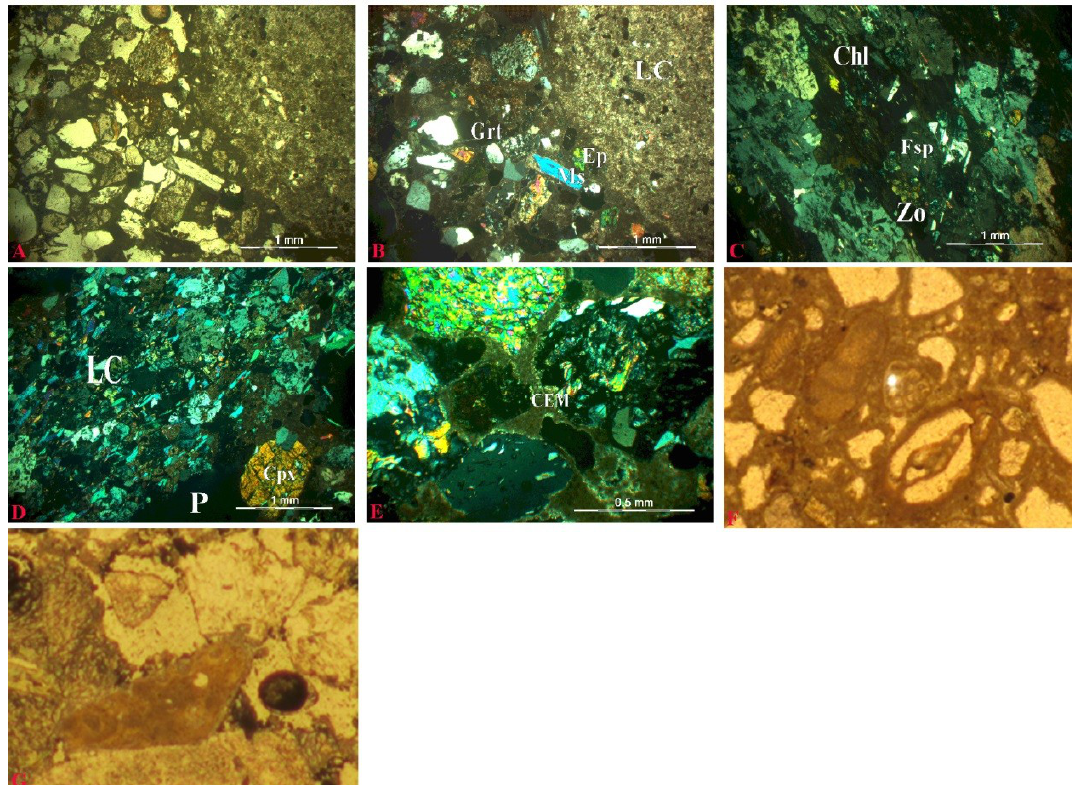
Figure 13. Photomicrographs of beachrock samples collected at area 2. ( A , B ): Clastic texture in parallel and cross polarized light respectively (XPL); ( C ): Lithoclast of epidote-chlorite schist participating in microstructure (XPL); ( D ): Lithoclast of mica schist participating in microstructure (XPL); ( E ): Cement fills pores, coats grains, and forms bridges between particles. (XPL); ( F ): Presence of foraminifera and algae in microstructure (x 352); ( G ): Presence of bone in microstructure (x 640). CEM: cement; Cpx: clynopyroxene; Ep: epidote; Fsp: feldspar; Grt: garnet; LC: lithoclast; Ms: muscovite; P: pore; Zo: zoisite.